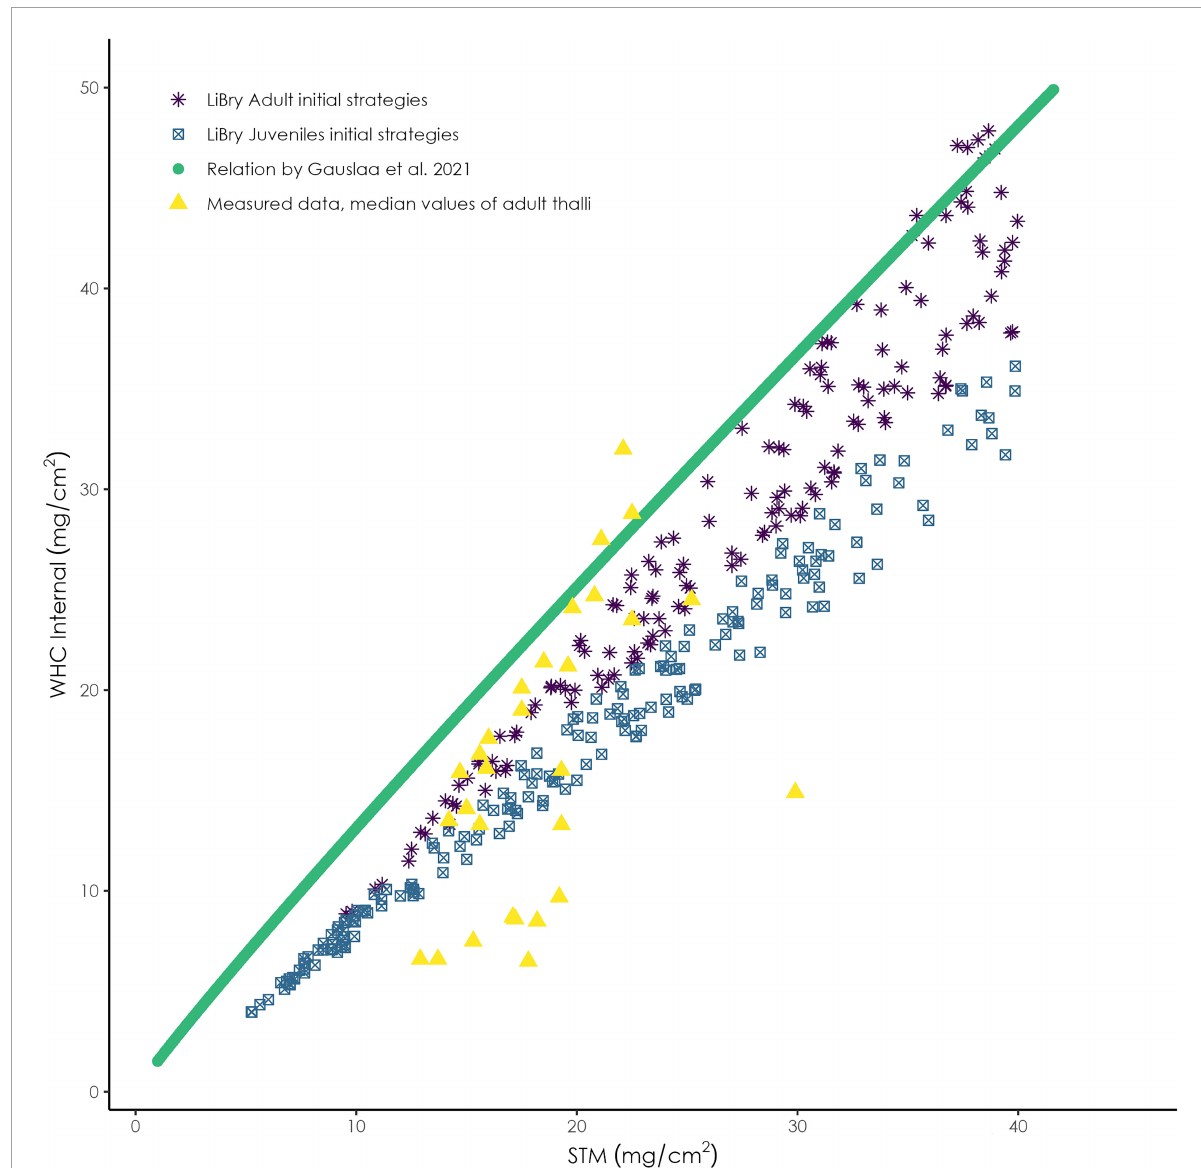
FIGURE4 Relation between STM and internal WHC for the initial adult and juvenile strategies in the LiBry model and of measured adult thalli. The scatter in the strategies results from the free variation of several morphological parameters in the model, such as thallus height and the relative fractions of water and air in different parts of the